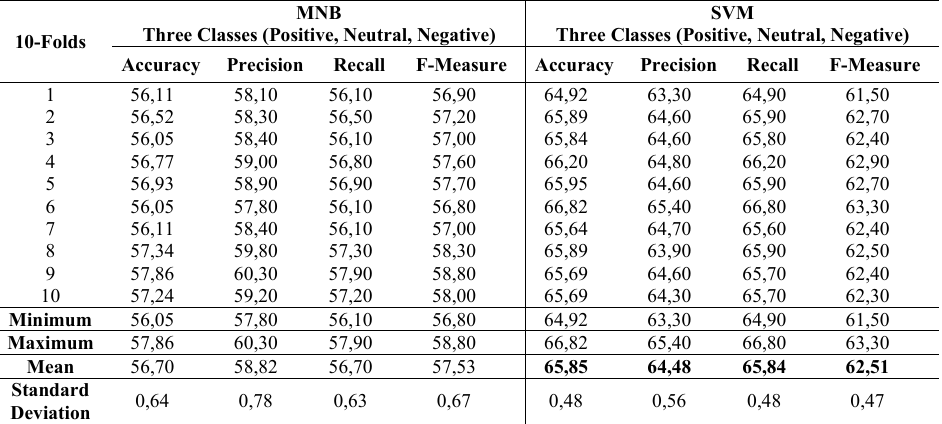
TABLE 2 C LASSIFICATION R ESULTS OF THE E CONOMIC A SPECT USING THREE